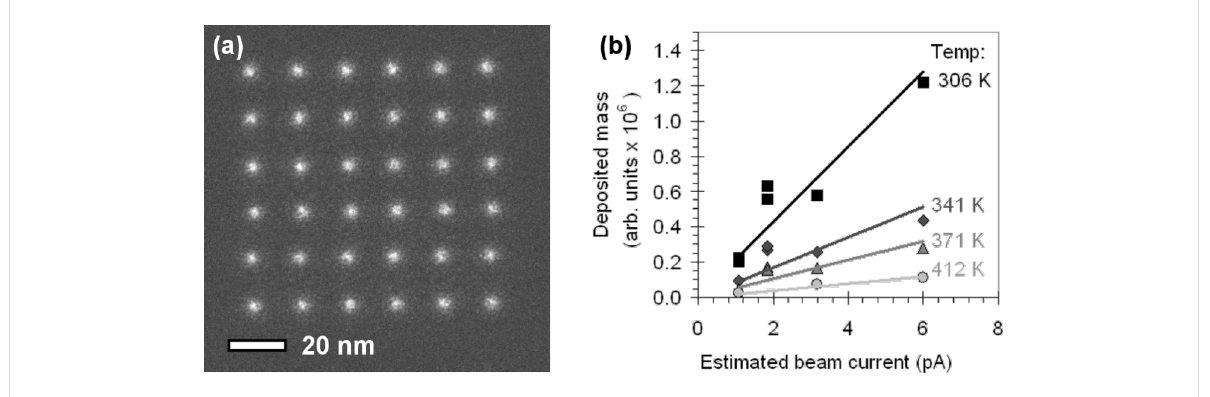
Figure 1: (a) An array of dots written at a substrate temperature of 306 K (33 °C) and a dwell time of 3 s per dot. (b) The deposited mass as a func- tion of beam current and substrate temperature. The dwell time was 3 s per dot for all arrays.